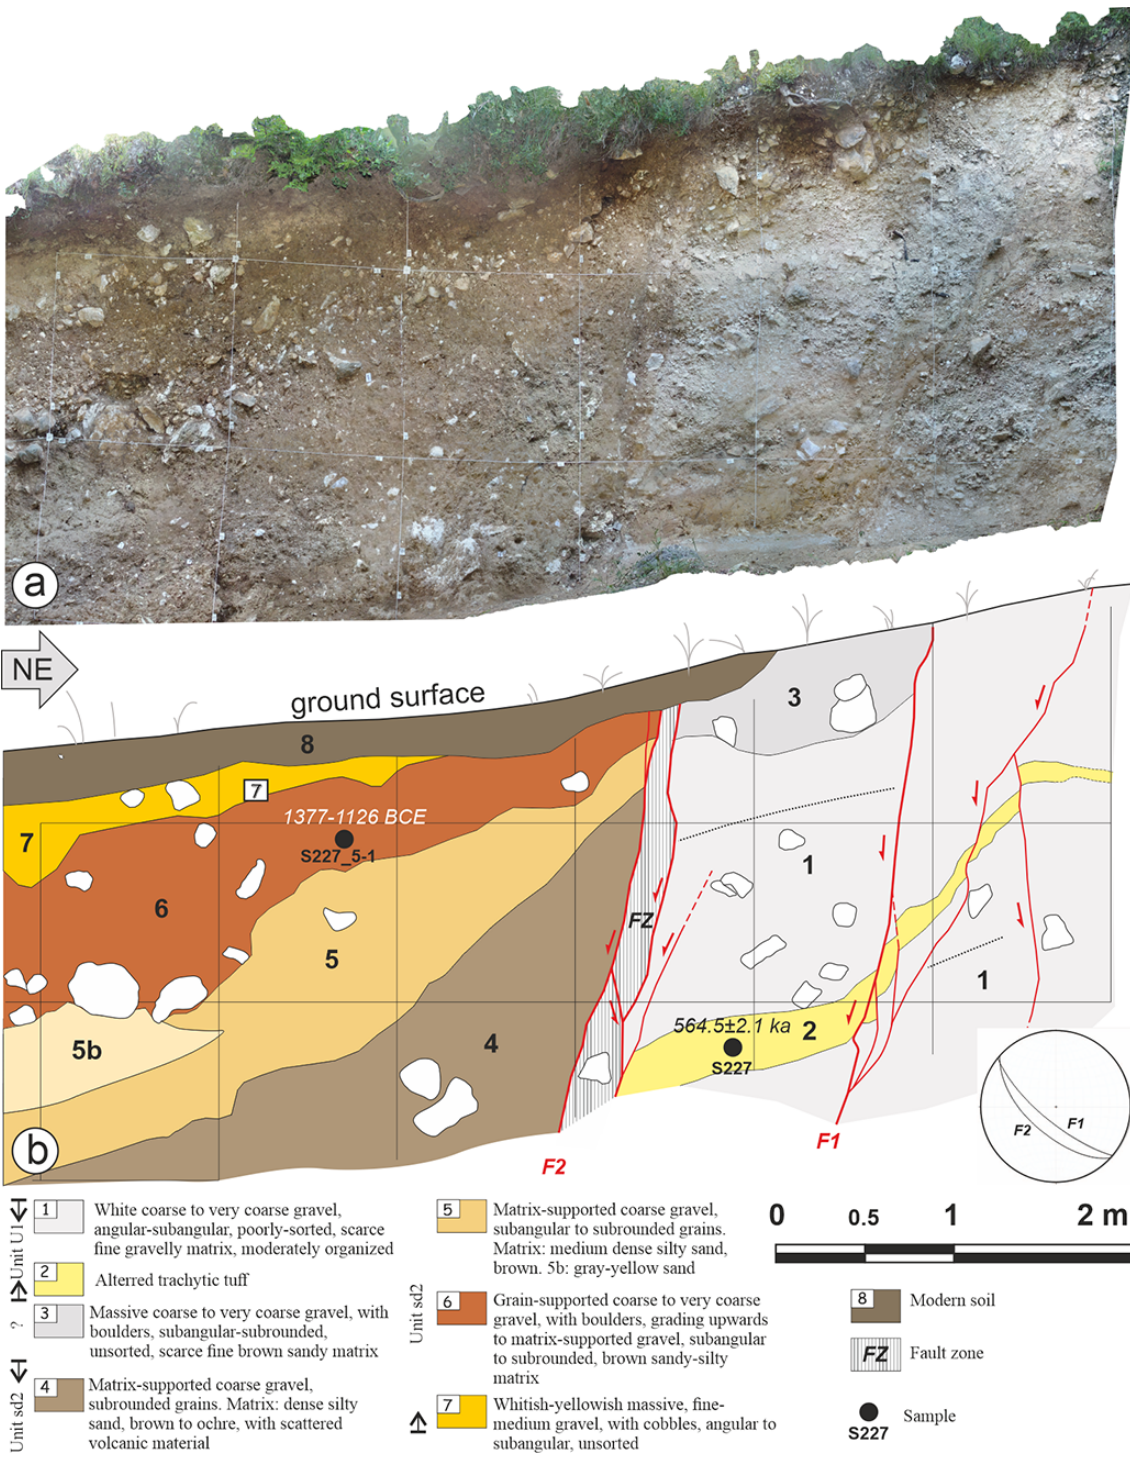
Figure 8. Photomosaic (a) and interpreted log (b) of fault zone 1 in the western splay of the Gioia Sannitica normal fault (San Potito fault section, central part). Unit numbering (1 to 8) refers only to this outcrop (units do not necessarily correlate with other units with the same number in Figs. 9 and 10); the stratigraphic position of units U1 and sd2 is indicated in Fig. 3. The complete details of the age determinations are given in Tables 1, 2, and S1. The location of this outcrop is given in Figs. 2b and 4.